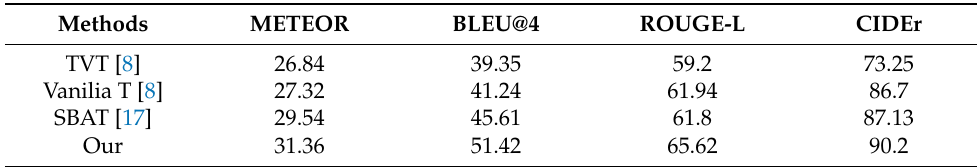
Table 3. Test results on BUUSIE test sets.